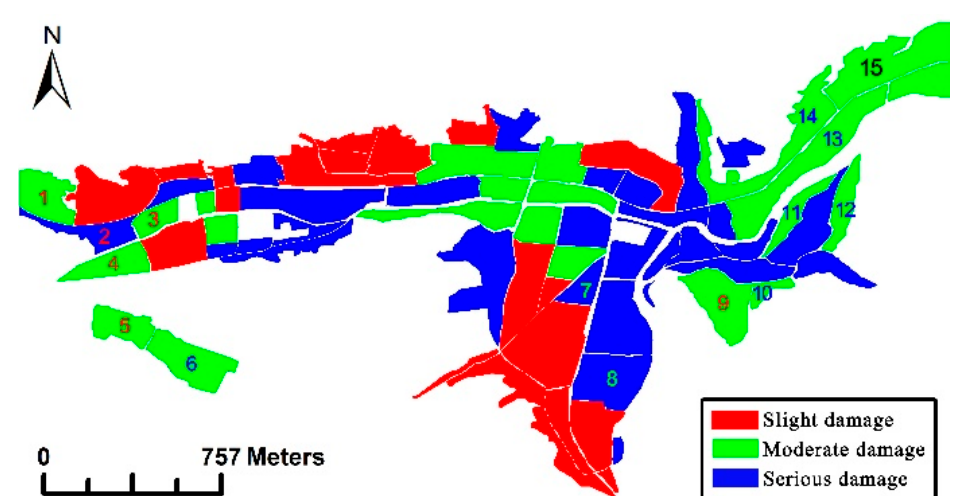
Figure 15. Extraction results of CB, undamaged buildings (UDB), and nonbuildings (NB) in the earthquake-hit urban area of Yushu County.